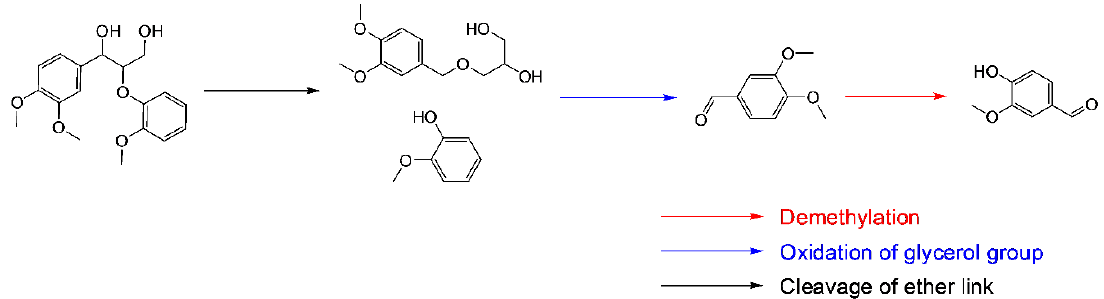
Figure 1. Potential reaction pathway for aerobic oxidation of lignin to vanillin via a series of reactions [37] .